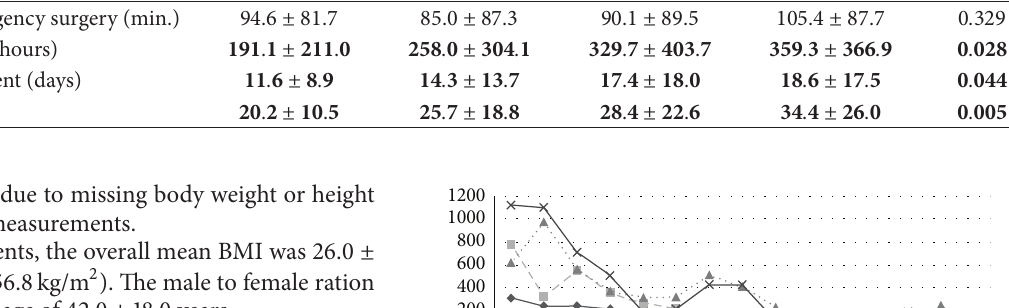
Table 2: Clinical course according to the BMI. Underweight Normal